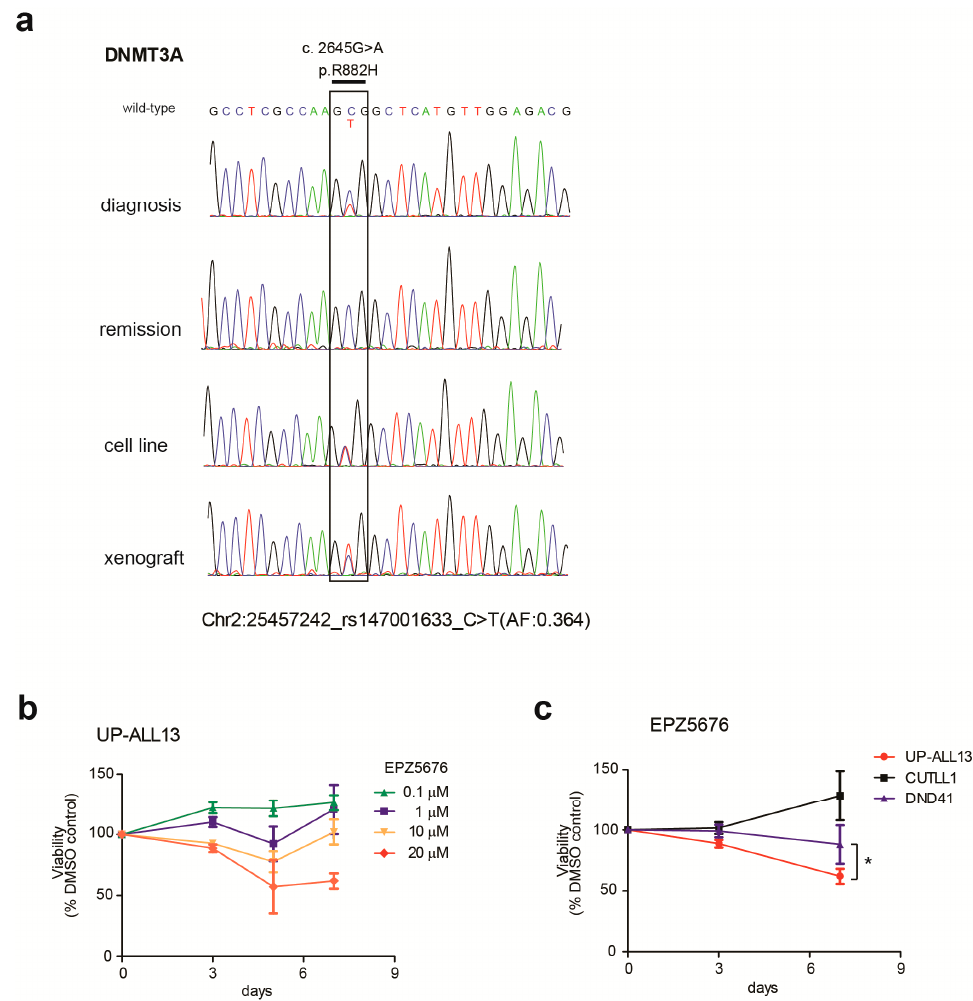
Figure 3. Mutational analysis of the DNMT3A mutational hotspot (R882) and response of the UP-ALL13 cell to the DOT1L inhibitor EPZ5676. ( a ) Sanger sequencing of UP-ALL13 cells validates the point mutation (c.2645G > A; pR882H) affecting the DNMT3A gene, as identified by whole exome sequencing (WES) in the patient leukemia cells at diagnosis. ( b ) Cell viability of UP-ALL13 cells treated for up to 7 days with different doses of the DOT1L inhibitor EPZ5676. Viability is shown as a percentage of the Dimethyl Sulfoxide (DMSO) control cells at each time point. Error bars represent ± standard deviation of quadruplicate wells. ( c ) Cell viability of UP-ALL13, CUTLL1, and DND41 cells treated for 3 and 7 days with a dose of 20 µ M of EPZ5676. Viability is shown as a percentage of the DMSO control cells at each time point. Error bars represent ± standard deviation of quadruplicate wells. *, p < 0.05.